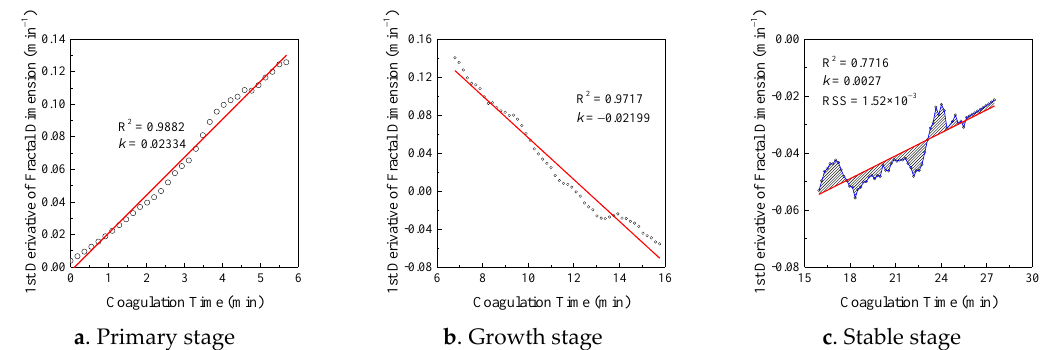
Figure 7. Linear fit of the first derivative of particle size fractal dimension with coagulation time. ( a ) In the primary stage; ( b ) in the growth stage; and ( c ) in the stable stage.